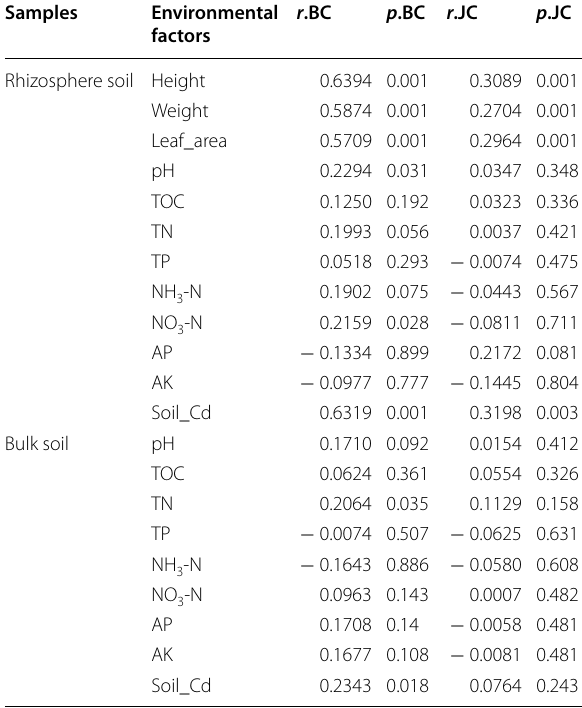
Table 1 Mantel analysis of the relationship between the soil bacterial community structure in B. napus and environmental factors based on Bray Curtis (BC) and Jaccard (JC) method Samples Environmental r .BC p .BC r factors